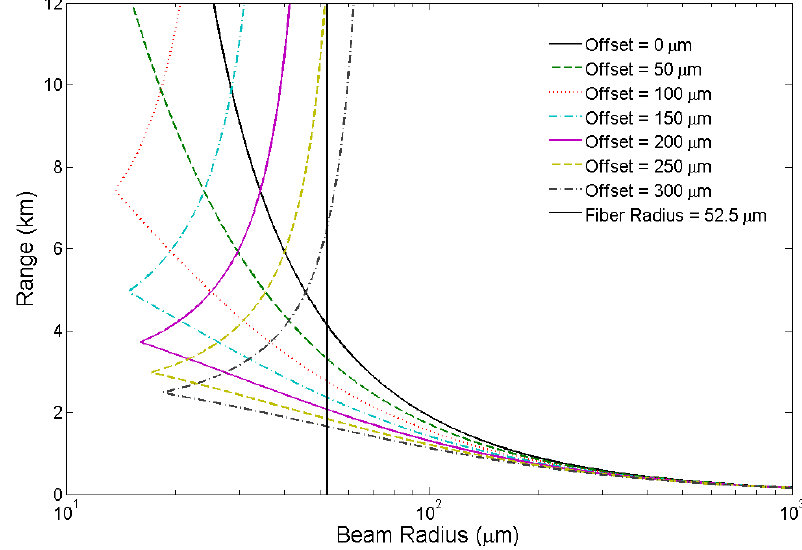
Figure 2. The beam radius at the optical fiber as a function of range and offset. The fiber radius is 52.5 μ m as is shown as the vertical solid black line. Overlap occurs when the beam radius is less than the fiber